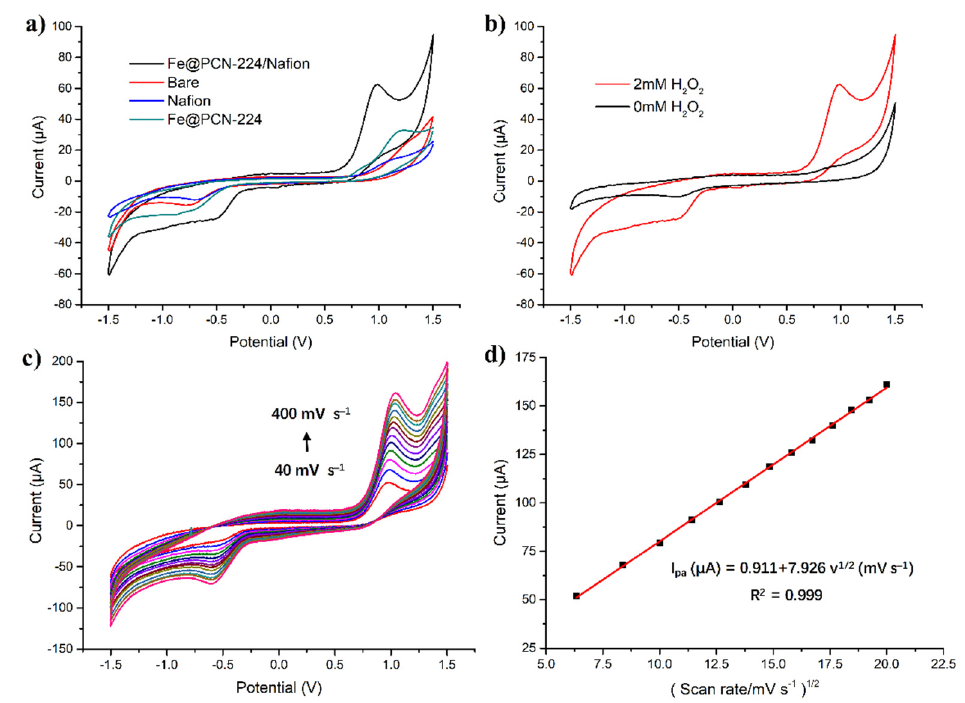
Figure 3. Cyclic voltammograms of ( a ) the Fe@PCN-224/Nafion/GCE, bare, Nafion, and Fe@PCN- 224-modified GCE with 2 mM H 2 O 2 and ( b ) Fe@PCN-224/Nafion/GCE with (red curves) or without (black curves) 2 mM H 2 O 2 in pH 7.0 phosphate buffer recorded at scan rate of 50 mV s − 1 , respectively. ( c ) Cyclic voltammograms of Fe@PCN-224/Nafion/GCE for 2 mM H 2 O 2 in different scan rates (40, 70, 100, 130, 160, 190, 220, 250, 280, 310, 340, 370 and 400 mV s − 1 ). ( d ) The relationship between peak currents and scan rates.